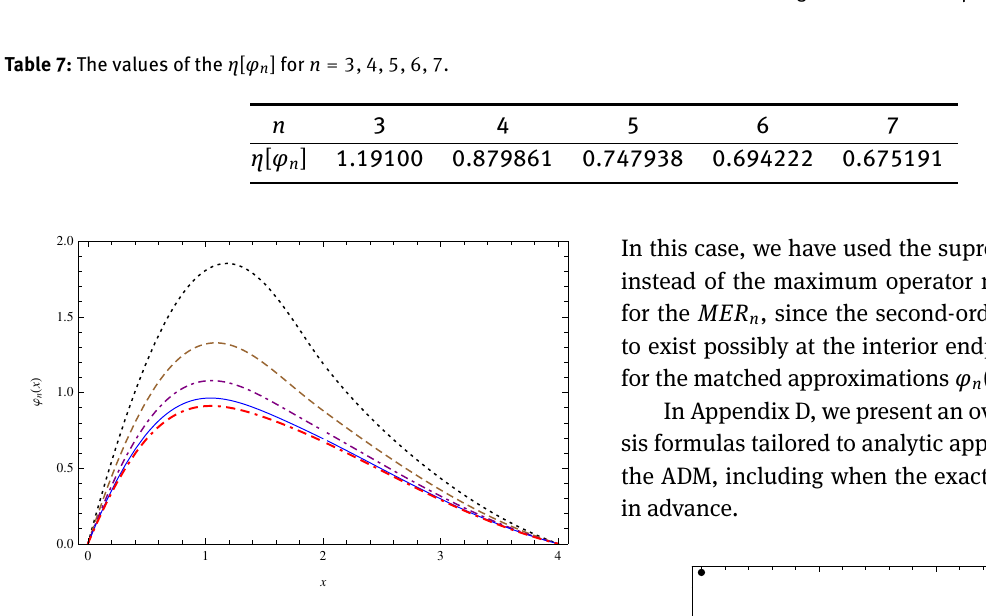
Figure 10: Curves of the matched n th-stage approximations φ n ( x ) for n = 3 (dot line), n = 4 (dashed line), n = 5 (dot-side line), n = 6 (solid line), and n = 7 (dot-side-side line).